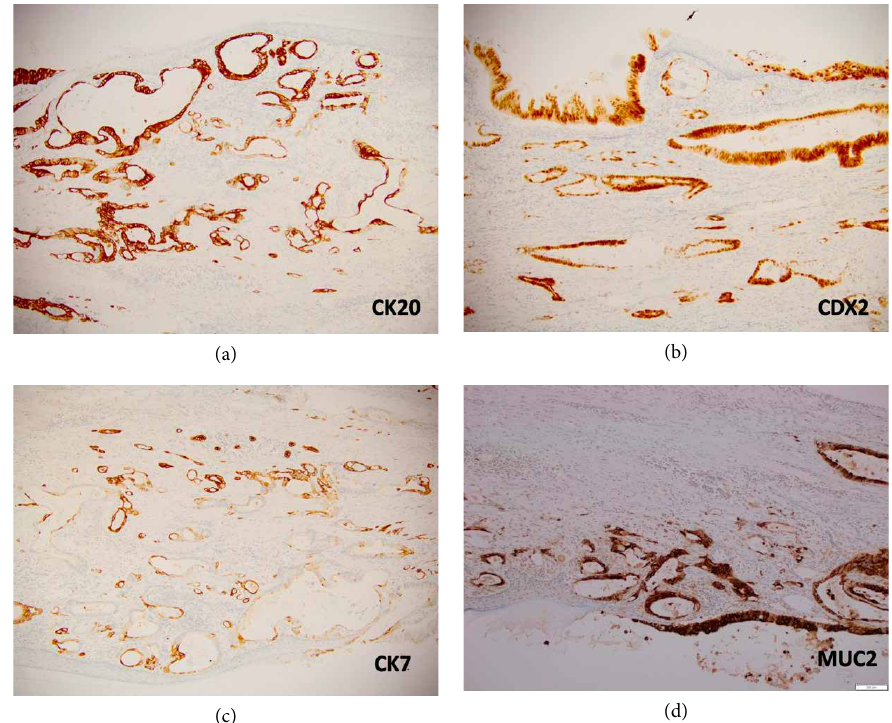
Figure 3: (a) CK20 is strongly positive in tumour. (b) CDX2 in strongly positive in tumour cell nuclei. (c) CK7 is patchy variable positive. (d) MUC-2 is strongly